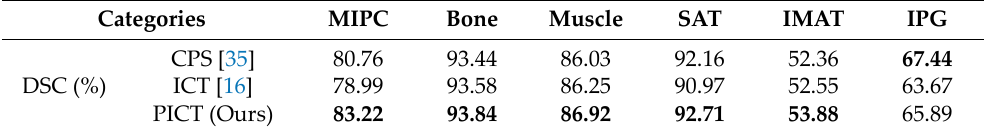
Table 7. Comparison of DSC score (%), mIoU (%), mAcc (%) indexes of the 6 categories with 40 labeled images as an example on Multi‑tissue Pelvic. The bold fonts indicate the best results of the comparing